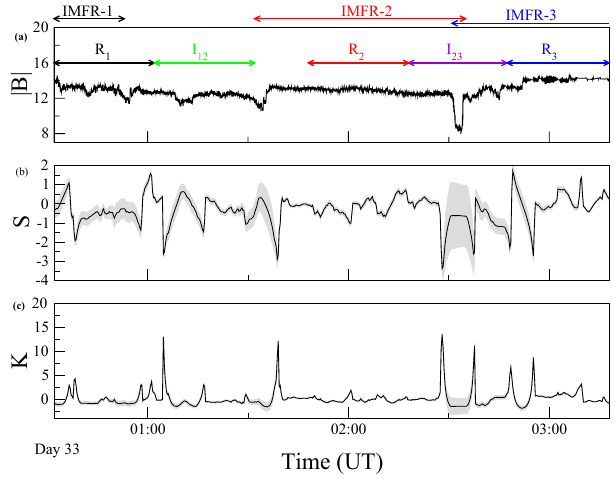
Figure 2. (a) Time series of | B | from 00:32 to 03:18UT on 2 Febru- ary 2002. Five regions of 30min each are highlighted using different colors: interior of IMFR-1 ( R 1 , black), interface region of IMFR- 1 and IMFR-2 ( I 12 , green), the interior of IMFR-2 ( R 2 , red), the interface of IMFR-2 and IMFR-3 ( I 23 , violet), and the interior of IMFR-3 ( R 3 , blue). The interval of each IMFR is indicated by hor- izontal arrows as in Fig. 1. (b, c) Time series of the skewness S and the kurtosis K computed using a sliding overlapping window of size 10000 data points and a window shift of 400 data points. The SD computed in each window is represented by a gray